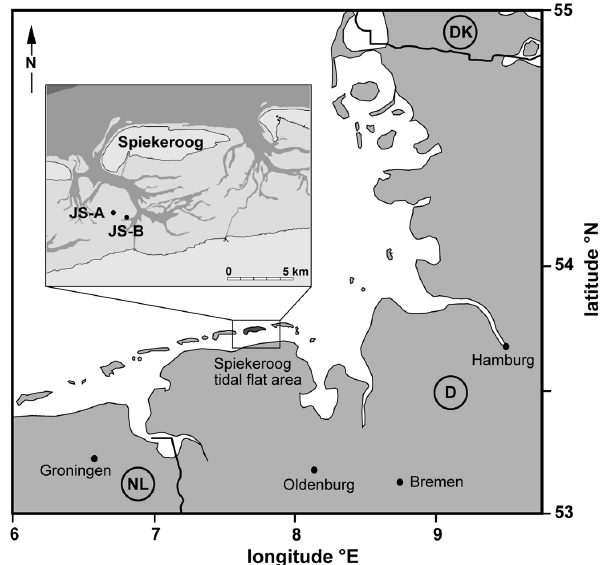
Fig. 1. Study sites JS-A and JS-B on the tidal flat Janssand located close to Spiekeroog Island in a tidal area stretching along the coasts of the Netherlands (NL), Germany (D), and Denmark